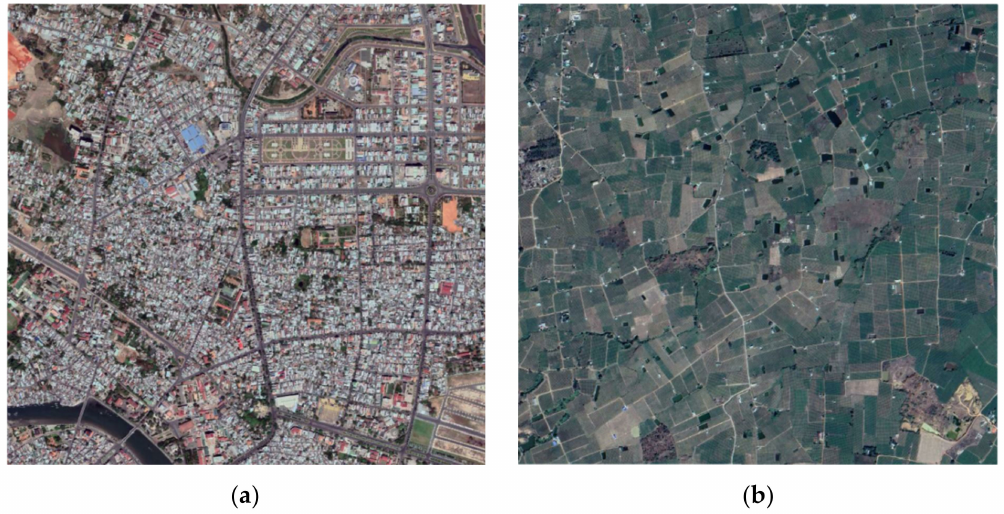
Figure 15. Selected 2 km by 2 km areas for comparison. ( a ) Aerial image of the urban area on 6 March 2018 and ( b ) aerial image of the dragon fruit croplands on 12 February 2018.